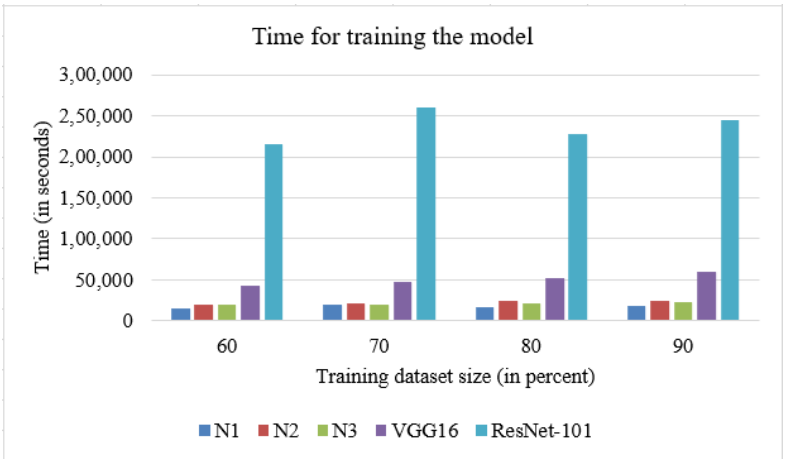
Figure 9. Training time for deep learning networks with varying training dataset